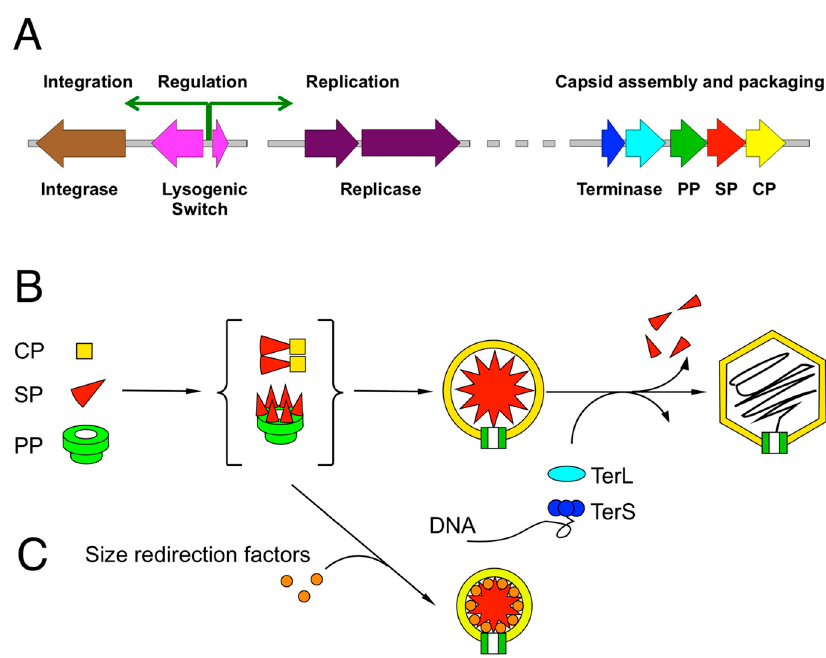
Figure 1. The bacteriophages of the Caudovirales . ( A ) Typical modules found in Caudovirales genomes, including integration, replication and capsid assembly / DNA packaging modules. ( B ) General assembly pathway for bacteriophages. Precursor procapsids are formed from capsid protein (CP), scaffolding protein (SP) and portal protein (PP) through poorly characterized CP-SP and/or PP-SP intermediates (curly brackets). In some systems, the SP functionality is fused to CP. Procapsids are packaged with DNA by the terminase complex (TerL and TerS), leading to capsid expansion and removal of SP. ( C ) Size redirection factors encoded by “pirate” MGEs shunt the capsid assembly pathway to small capsid formation.